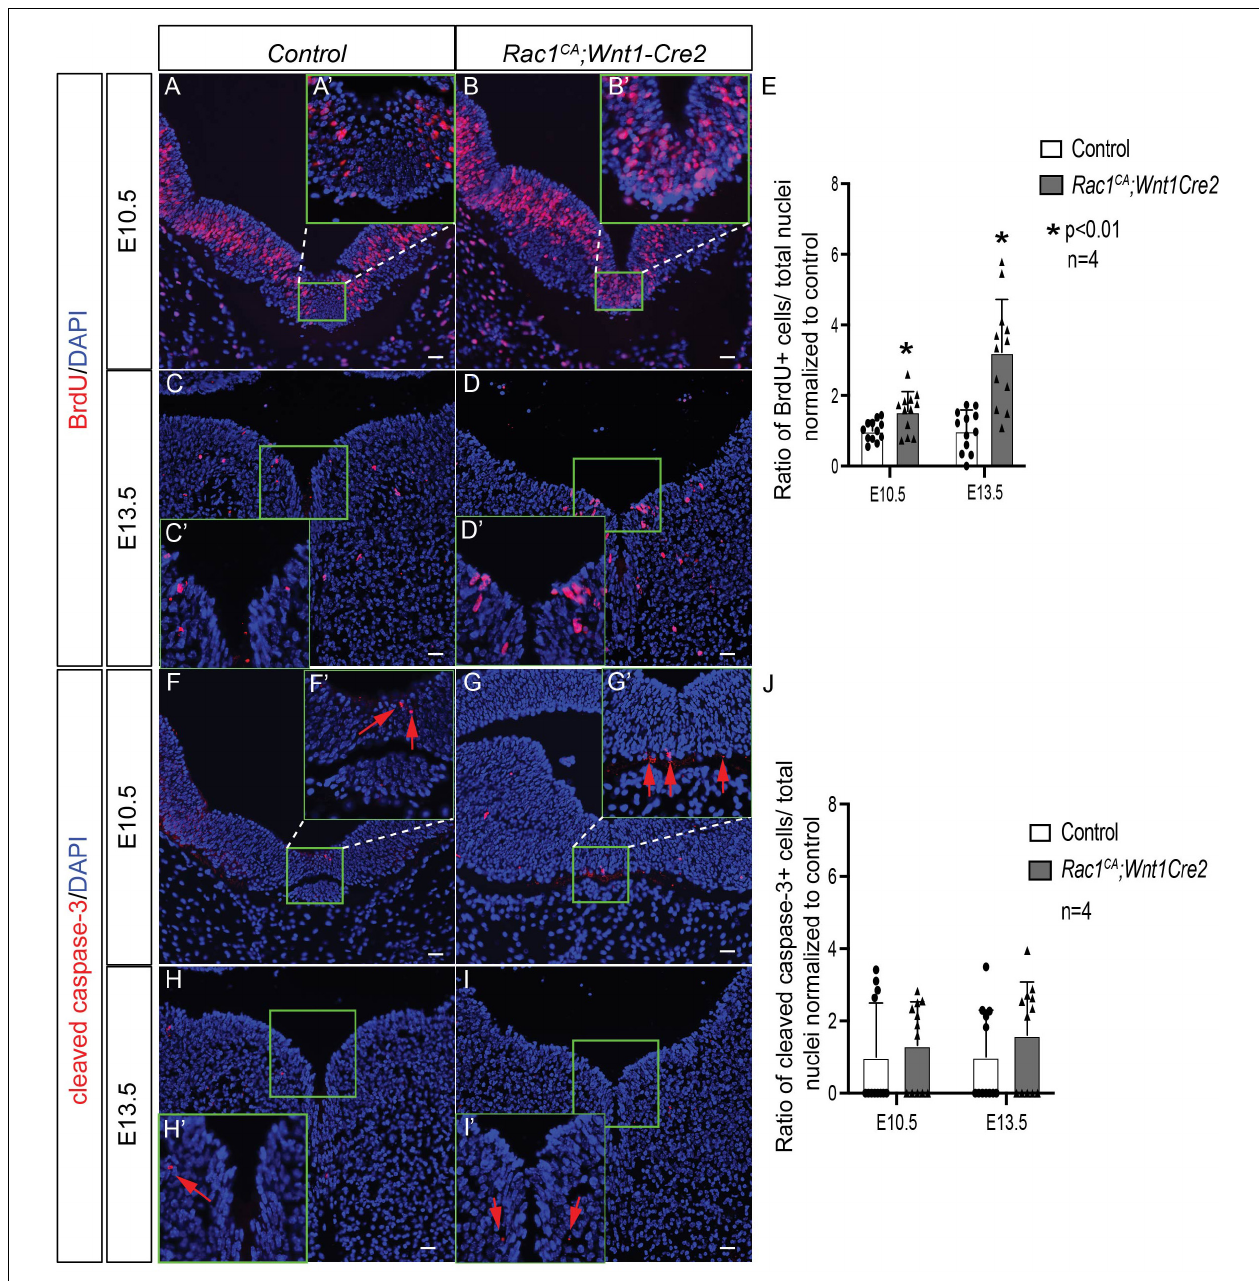
FIGURE 5 | Analysis of cell proliferation and apoptosis of Rac1 CA ;Wnt1-Cre2. (A–D) BrdU labeling (red) on coronal sections of midbrain in littermate control (A,C) and Rac1 CA ;Wnt1-Cre2 (B,D) at E10.5 (A,B) and at E13.5 (C,D) . Insets A’–D’ are magnification of defined areas in A–D . (E) Statistical analysis of quantification results in A–D . (F–I) Immunostaining using anti-cleaved caspase 3 antibody (red) on coronal sections of midbrain in littermate control (F,H) and Rac1 CA ;Wnt1-Cre2 (G,I) at E10.5 (F,G) and at E13.5 (H,I) . Insets F’–I’ are magnification of defined areas in F–I . Red arrows point to cells expressing cleaved caspase 3. (J) Statistical analysis of quantification results in F–I . Cells in ventral midbrain (green rectangles in A–D,F–I ) are quantified and used for statistical analysis. Scale bar in A–I , 10 µ m.